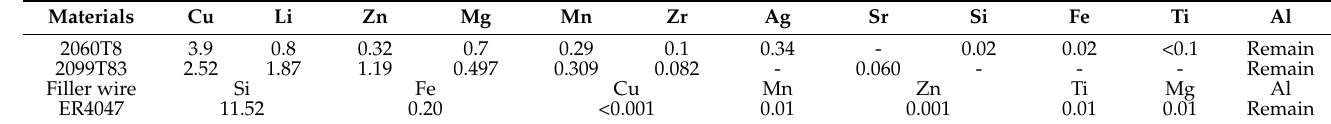
Table 1. 2060T8/2099T83 aluminum–lithium alloys and filler wire chemical composition and content (wt. %). Materials